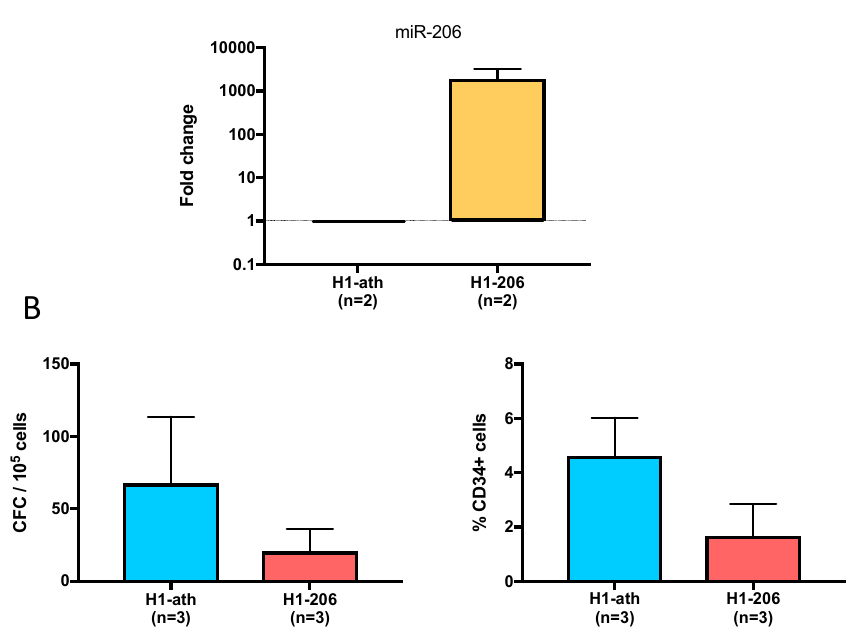
Figure 5. Inhibition of the hematopoiesis process by overexpression of miR-206 in a blood-competent ES cell line. The hematopoietic-competent H1 ES cell line was transduced with a lentivirus expressing either miR-206 (H1-206) or the ath-miR-159a negative control (H1-ath). ( A ) miR-206 average expression in H1-206 cells as compared to H1-ath cells. Fold changes were calculated by the 2 − ∆∆ Ct method with RNU48 as endogenous control; ( B ) The number of CFCs and the percentage of CD34+ cells in day-16 EBs (mean ± SD) are shown on the graphs for H1-ath control (blue bar) and H1-206 (red bar).